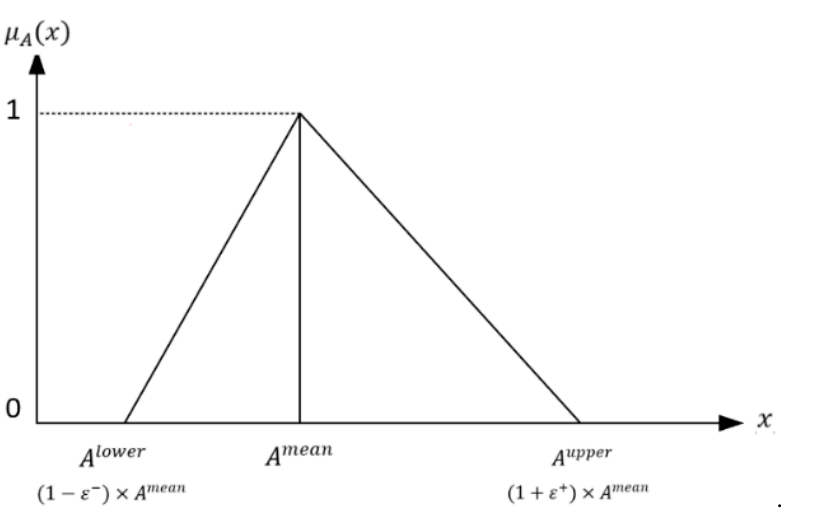
Figure 3. Fuzzy parameter membership function. Table 3. Fuzzy and non-fuzzy parameters.